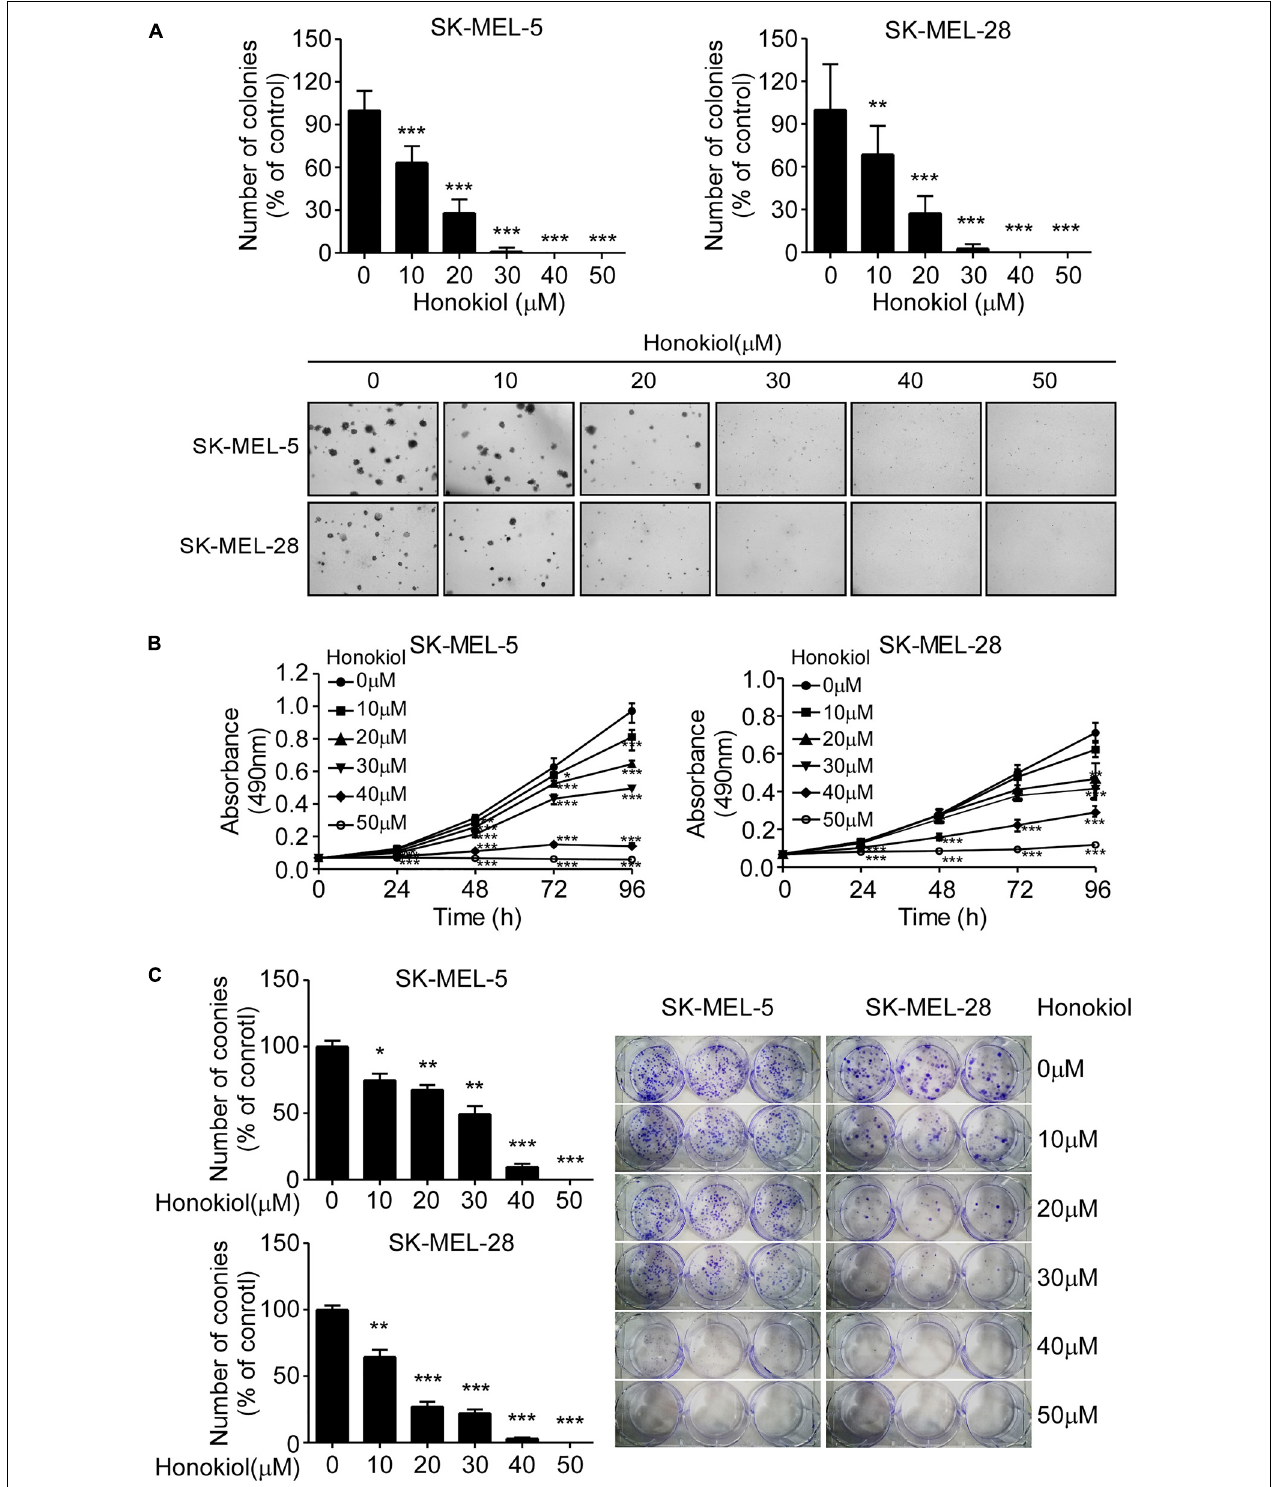
FIGURE 1 | Honokiol significantly inhibits the growth of melanoma cells. (A) Effect of honokiol on anchorage-independent growth of melanoma cells. Clone count (above); Representative images of anchorage-independent cell growth results (below). (B) Effect of different honokiol concentration on proliferation of melanoma cells, as assessed by MTT assay. (C) Effect of honokiol on colony formation potential of melanoma cells, as assessed by plate colony formation assay. Clone number (left); Representative images (right). The asterisks indicate a significant difference between honokiol treatment and untreated control (* p < 0.05, ** p < 0.01, and *** p <